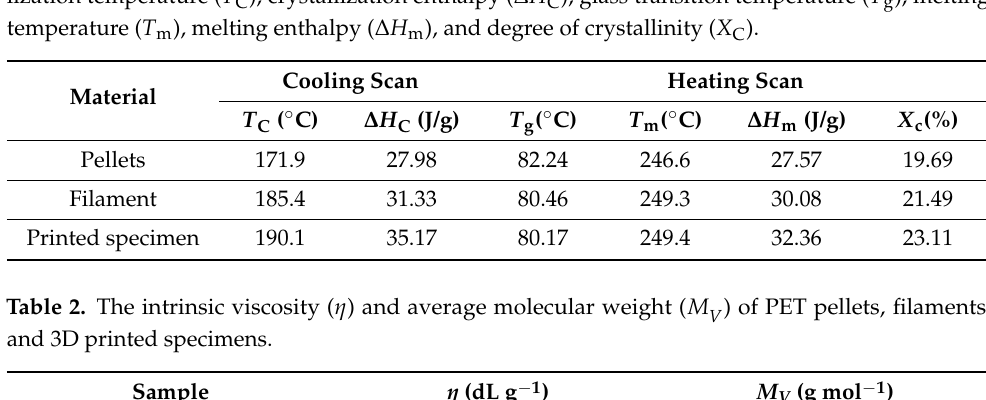
Table 1. Calorimetric parameters for PET pellets, extruded filament, and printed specimen: crystal- lization temperature ( T C ), crystallization enthalpy ( ∆ H C ), glass transition temperature ( T g ), melting